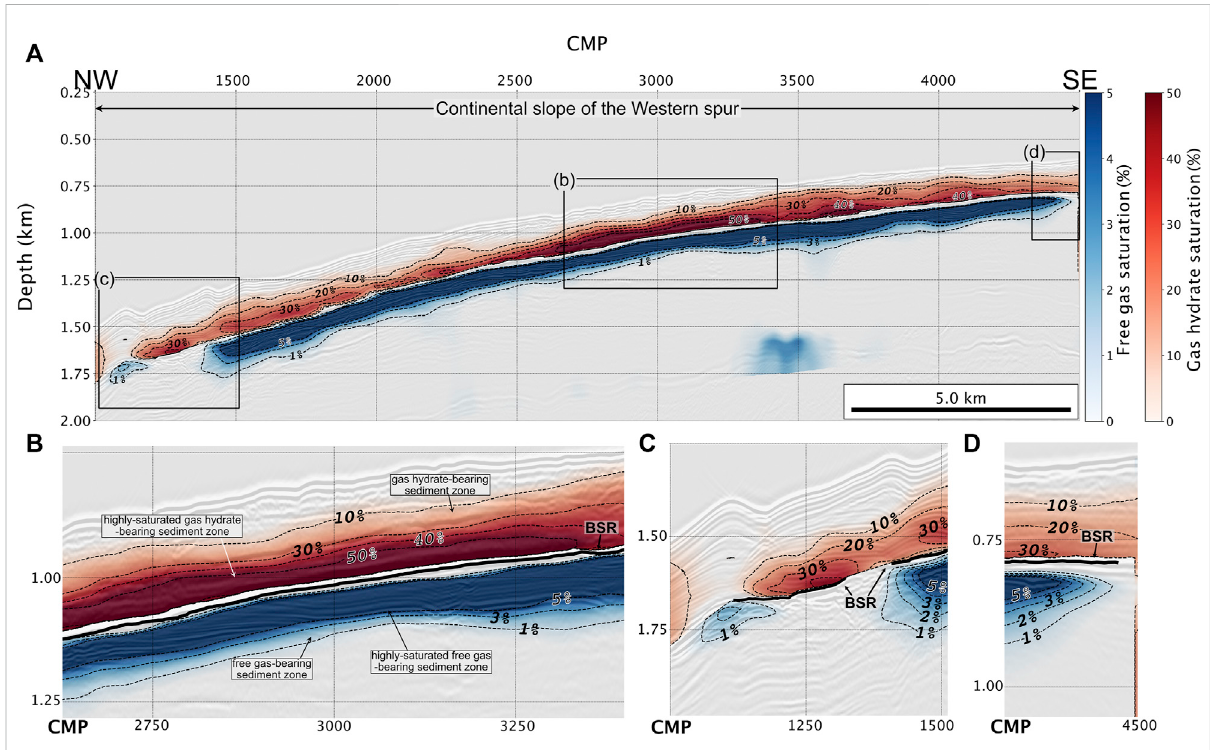
FIGURE 12 (A) Estimated gas hydrate, and free gas saturation model overlaid with migrated seismic images using the IMVA of the MCS04 line. The analysis range is marked on the solid red line in Figure 1C. (B) – (D) Enlarged velocity model: (B) continental slope of the western spur, (C) deepest area showing the BSR of the western spur, and (D) shallower area showing the BSR of the western